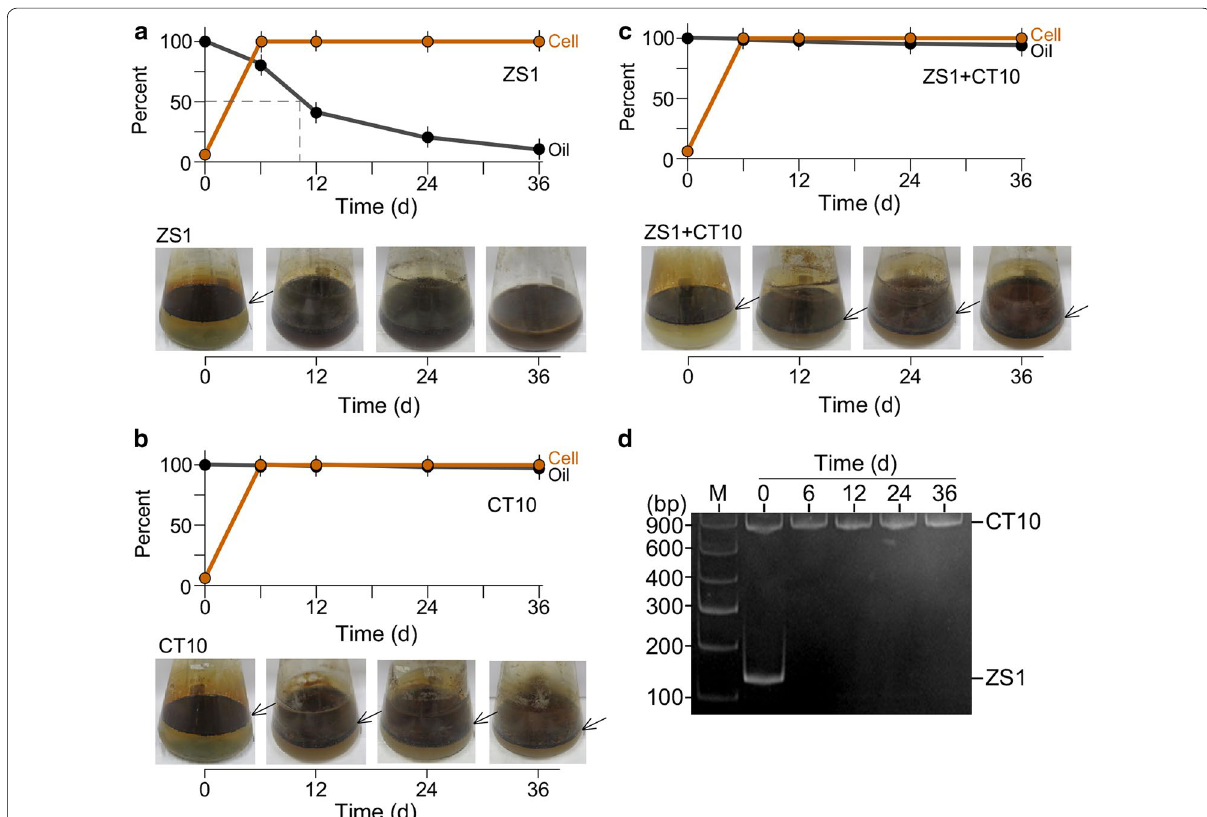
Fig. 4 Oil-eating activity of Pseudomonas sp. ZS1 is impeded in the presence of Alcaligenes sp. CT10. Arrow indicates the presence of floating oil on the surface of cultures. a Change of cell mass and crude oil quantity in ZS1 culture. Upper panel shows the percentage of cell mass (Cell) and crude oil mass (Oil) detected in cultures at various time points indicated. Bottom panel shows the presence (with arrow) or absence (without arrow) of floating oil in culture flask. The 50% reduction of crude oil occurs at 10 days after growth. b Change of cell mass and crude oil quantity in CT10 culture. The display is identical to a . c Change of cell mass and crude oil quantity in ZS1 and CT10 mixed culture. The display is identical to a . d Dynamic change of ZS1 and CT10 populations in mixed culture indicated in ( c )